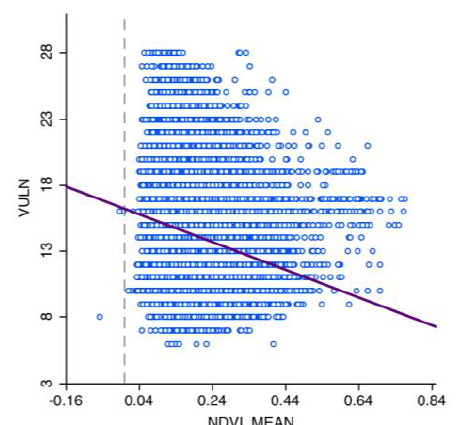
Figure 14 - Scatter plot for mean NDVI versus vulnerability index for Phoenix.